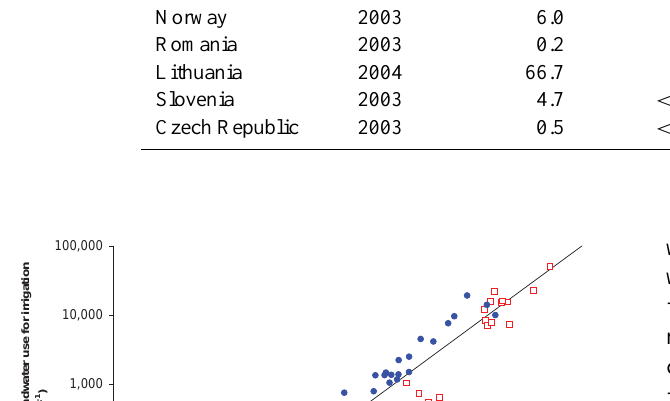
that all the irrigation water provided by off farm water networks belongs to the surface water category, ICWU GW computed by GCWM was 39% of the total ICWU and thus significantly larger than the percentage of groundwater abstraction for irrigation reported by Eurostat for Spain (16%). For Bulgaria the water use statistics reported that groundwater while at the same time, according to the farm structure survey, 13 980 ha (18% of total AAI) was irrigated mixed surface and groundwater. In Portugal